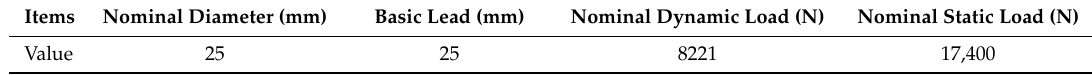
Table 8. Specifications of the selected ball screw unit.